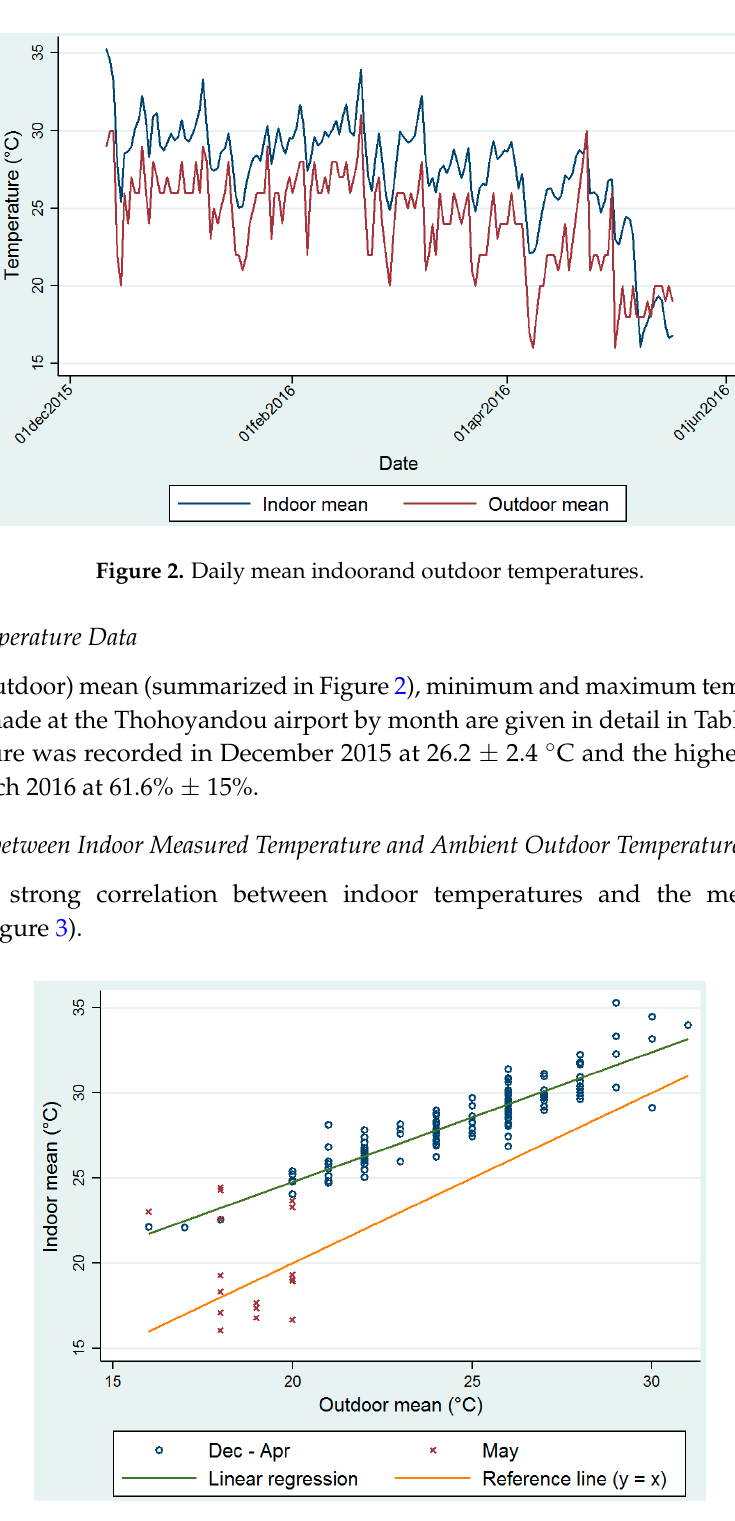
Figure 3. Linear regression for the period December to April between indoor and outdoor daily mean temperatures (intercept β 0 = 9.5, se( β 0 ) = 0.72, slope β 1 = 0.8, se( β 1 ) = 0.03, model R 2 =